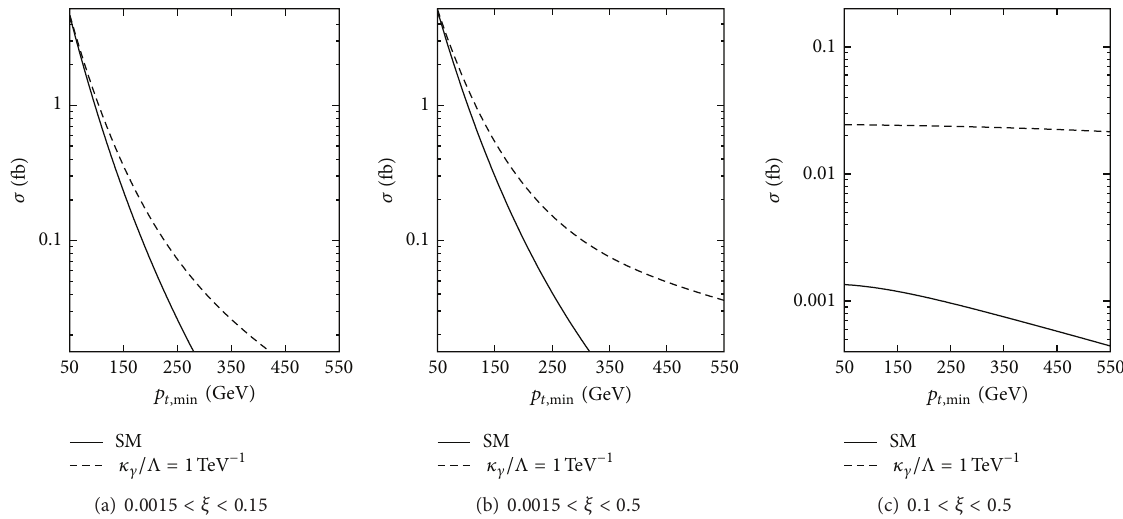
Figure 1: The SM and total cross sections of 𝑝𝑝 → 𝑝𝑞𝑞𝑝 ( 𝑞 = 𝑢,𝑐 ) process as a function transverse momentum cut ( 𝑝 𝑡, min ) on the final state quarks for three forward detector acceptances: 0.0015 < 𝜉 < 0.15 , 0.0015 < 𝜉 < 0.5 , and 0.1 < 𝜉 < 0.5 . 𝑚 𝑡 󸀠 and 𝜅 𝛾 /Λ is taken to be 700 GeV, 1TeV −1 , respectively.